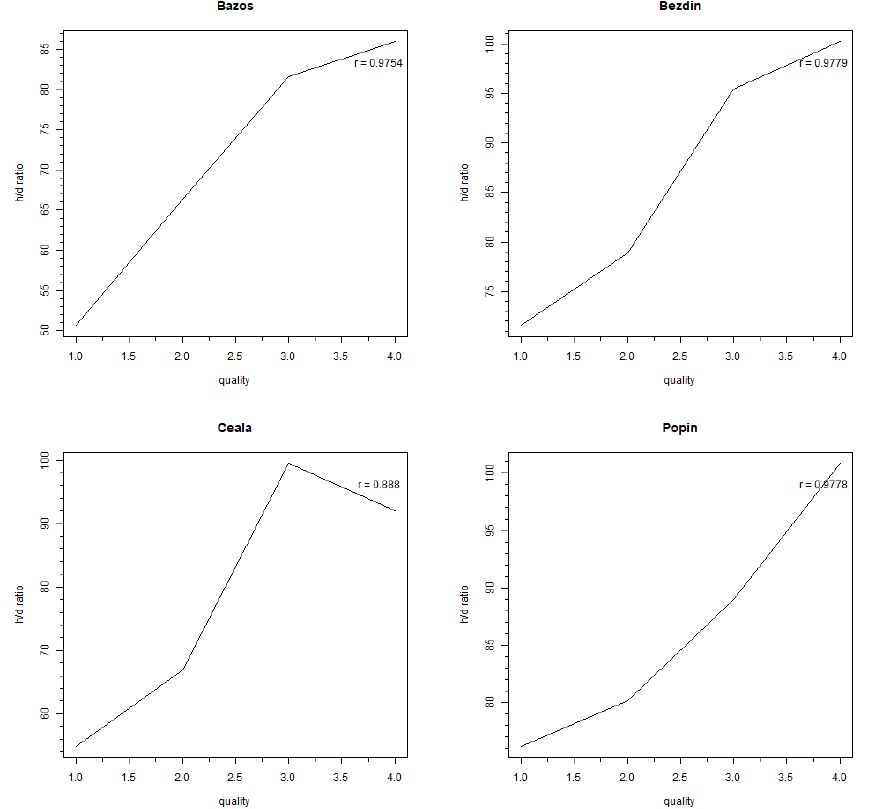
Figure 4. Relationship between h/d ratio and wood